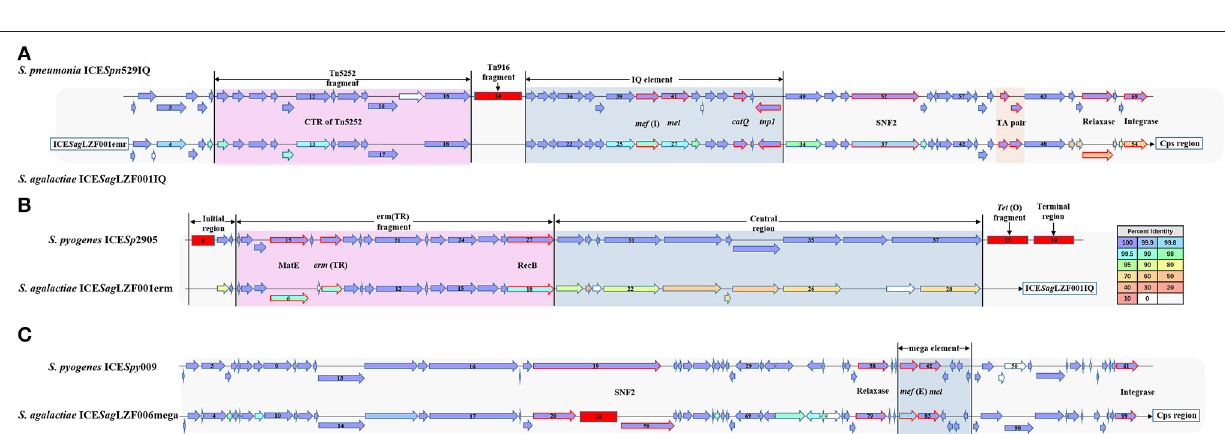
FIGURE 4 | Gene organization of putative integrative conjugative element ICE Sag LZF001IQ, ICE Sag LZF001erm, and ICE Sag LZF006mega. (A) Schematic representation of ICE Sag LZF001IQ with ICE Spn 529IQ as the genetic reference. (B) Schematic representation of ICE Sag LZF001erm with ICE Sp 2905 as the genetic reference. (C) Schematic representation of ICE Sag LZF006mega with ICE Spy 009 as the genetic reference. The arrows indicated the direction of the transcription. The color of the arrow was correlated with the percent identity. The arrows with red border were annotated the gene information. The deletion regions were shown with red rectangle. The number in the arrow indicated the serial number of ORFs, and the number in the red square indicated the number of ORFs within the